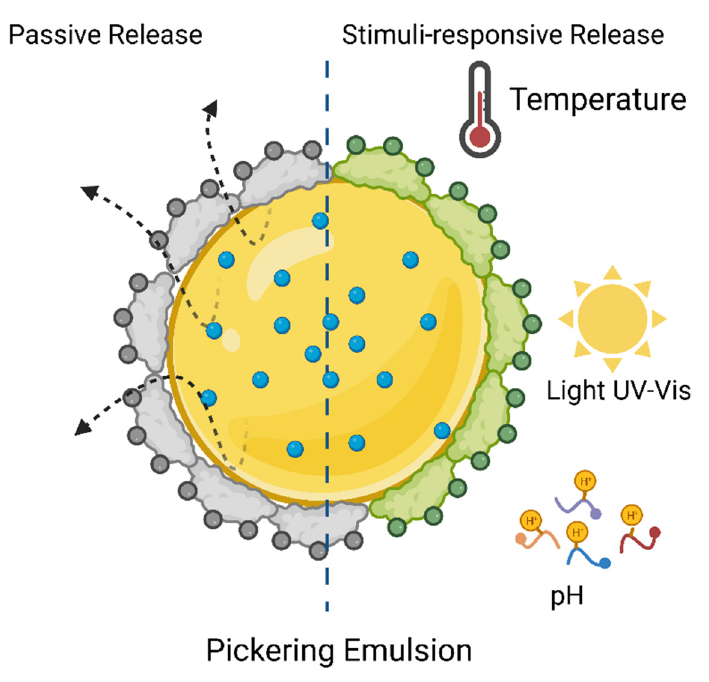
Figure 6. Structural form of Pickering emulsion and release mechanisms passive and stimuli-re- sponsive.